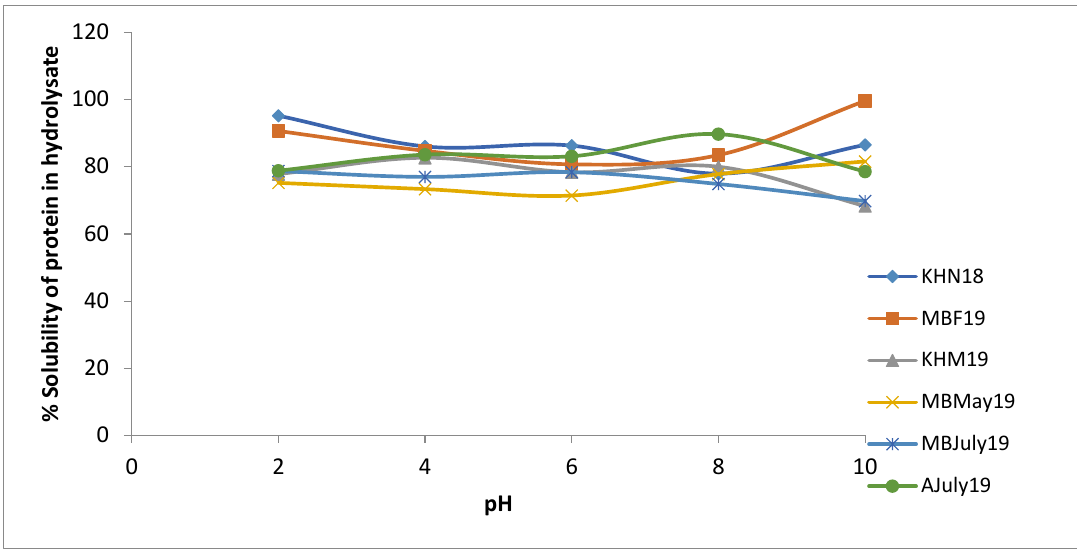
Figure 6. The percentage solubility of various mussel Protamex ® hydrolysates across a pH range of 2 to 10. Six representative samples from the three sampling sites, Mulroy bay, Killary harbour and Ardgroom, collected from November 2018 to July 2019, were used for analysis. Analysis was performed in triplicate (n = 3).